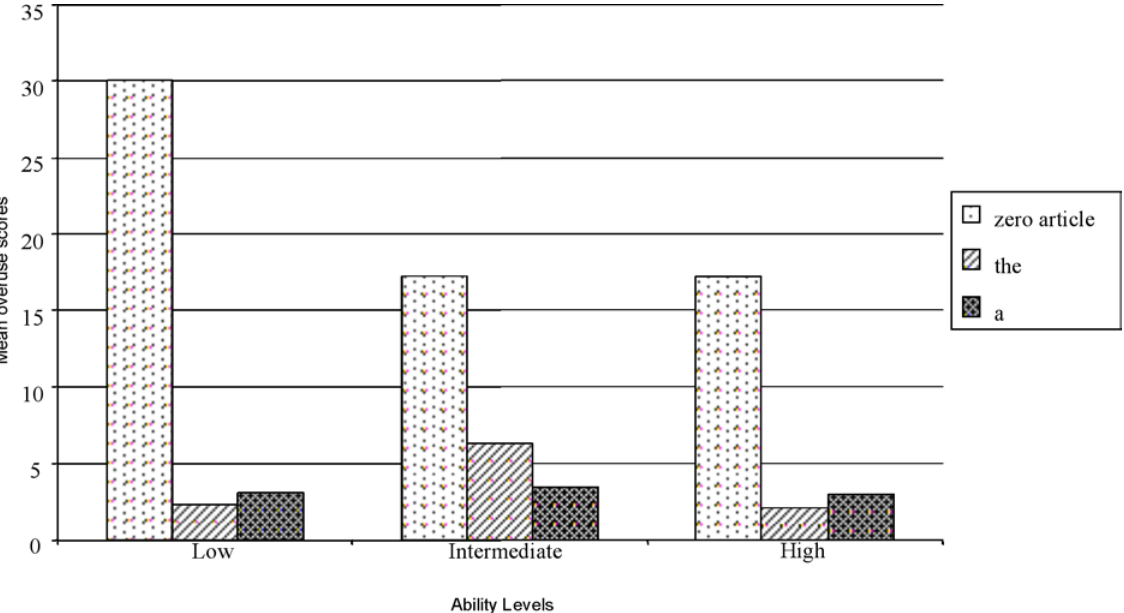
Mean Proportion Disparity of Unnecessary zero, the, and a by Ability